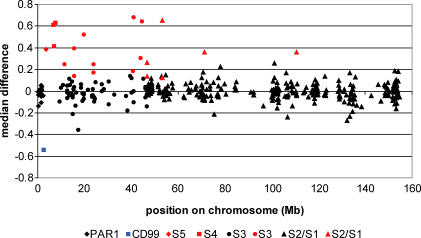
Genes Expressed More Highly in Females Are Distributed Non-Randomly on the X ChromosomeFor each gene, the median expression value for males was subtracted from the median expression value for females to give a median difference. Illustrated is the median difference for each gene based on averaging the values for the four populations, plotted according to location on the X chromosome. A median difference of 1 represents a 2-fold difference in expression. Different symbols represent different evolutionary strata. Genes expressed significantly more highly in females are coloured red, and the single gene expressed significantly more highly in males (CD99) is coloured blue.